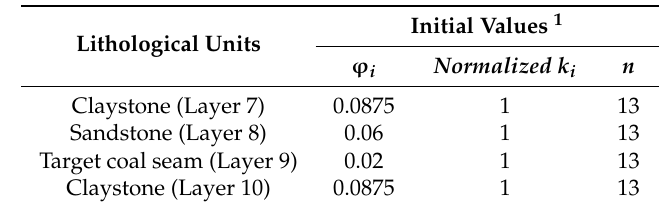
Table 3. Initial averaged data applied for permeability variation analysis (from Somerton [38]; Tian et al. [14] and Min [51]).